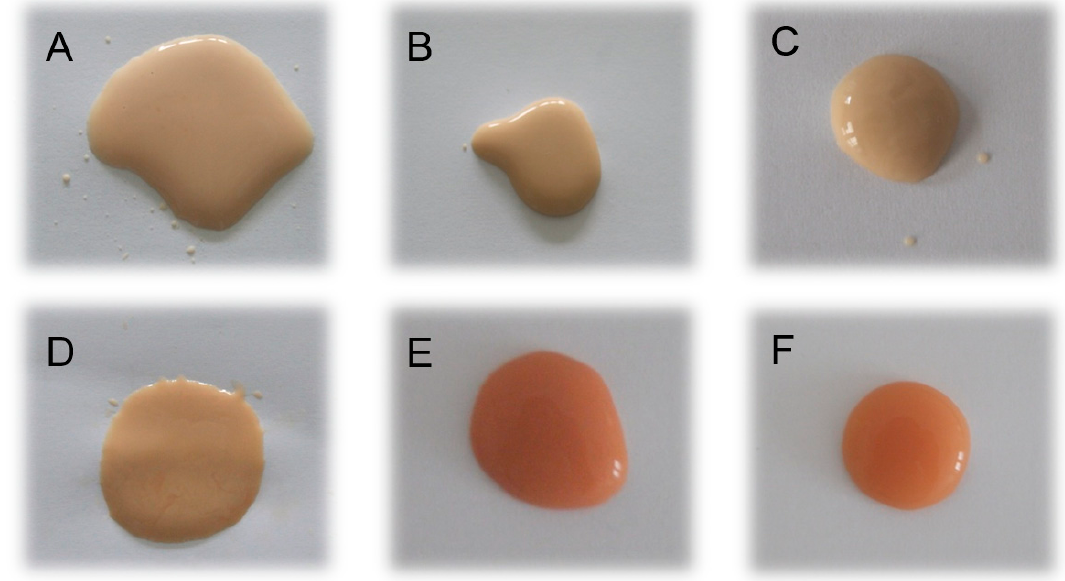
Figure 3. Selected images of wet cell biomass of C. utilis yeast from 72-h cultivation in the control (YPD) ( A ) and in the experimental media enriched with selenium (( B ) 4 mg / L; ( C ) 20 mg / L; ( D ) 30 mg / L; ( E ) 80 mg / L; ( F ) 100 mg / L).